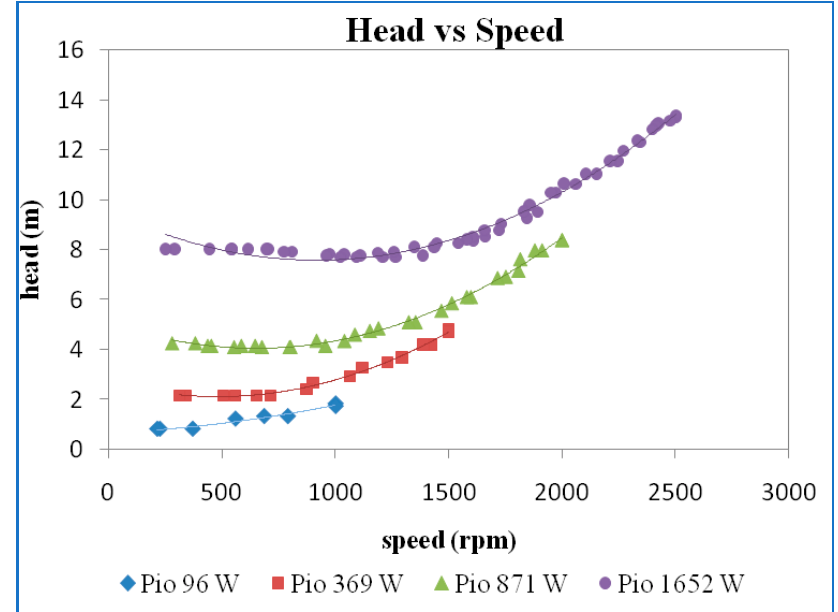
Figure 20. Head vs. speed at a guide vane opening of 19 mm.